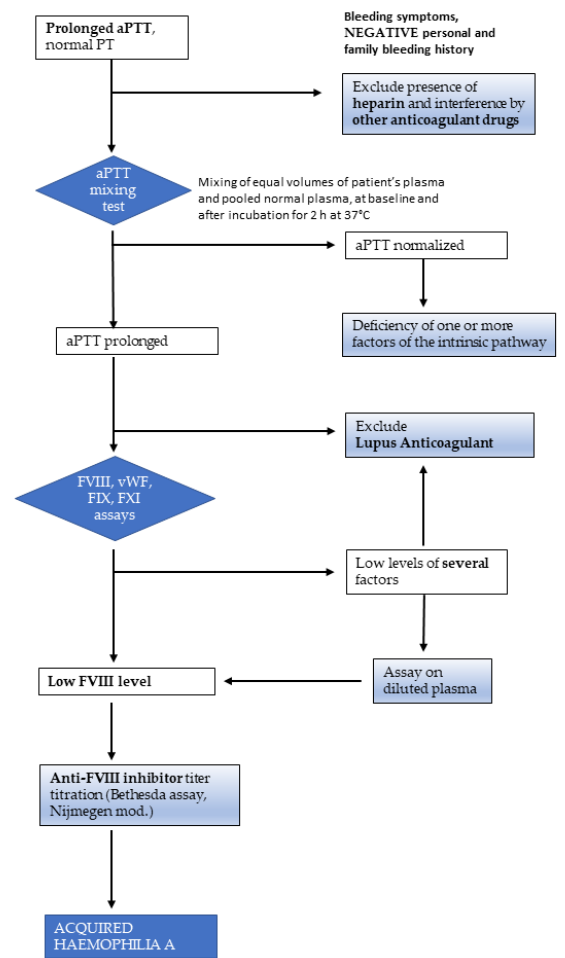
Figure 1. Diagnostic algorithm for acquired haemophilia A. Measurement of FXII level is not indicated in the presence of bleeding symptoms, because even severe deficiencies of this factor, which causes prolongation of the aPTT, are not associated with bleeding tendency. aPTT: activated partial thromboplastin time; PT: prothrombin time; FVIII: factor VIII; FIX: factor IX; FXI: factor XI; vWF: von Willebrand factor.